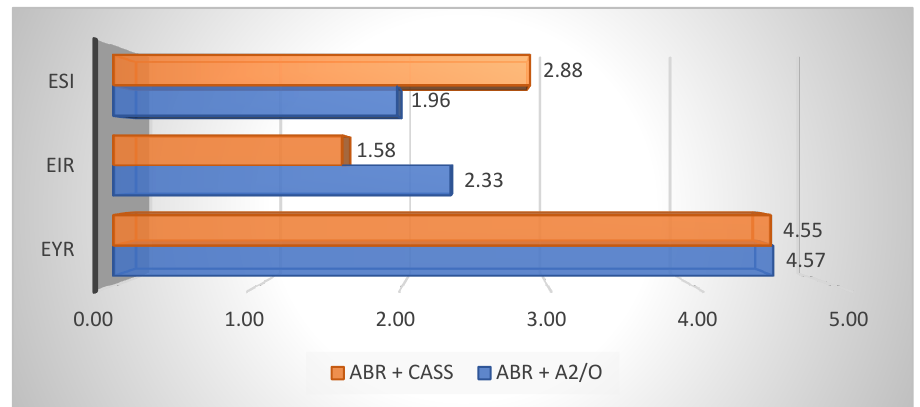
Figure 5. Results of emergy analysis for the two processes.